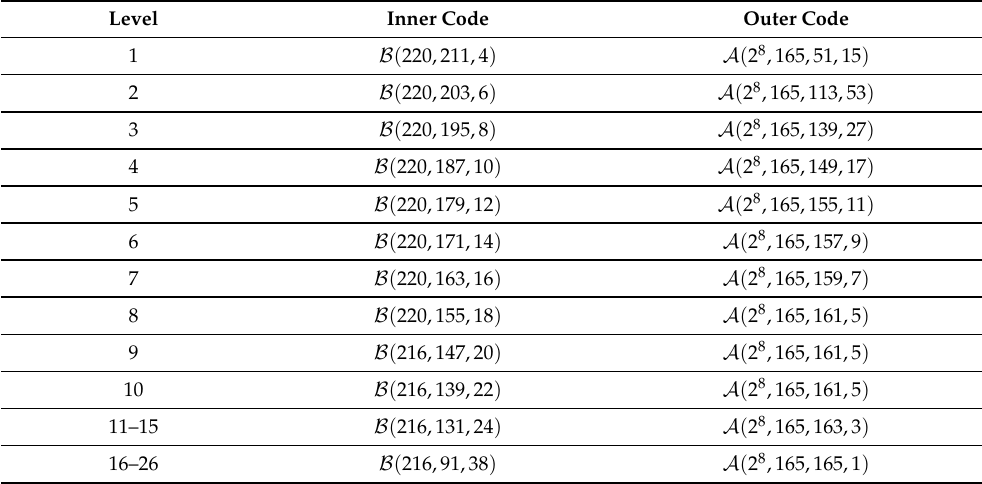
Table 5. Exemplary GC code ( N = 36,300, K = 32,783, R ≈ 0.9) for QLC (designed for WER 10 − 16 ).